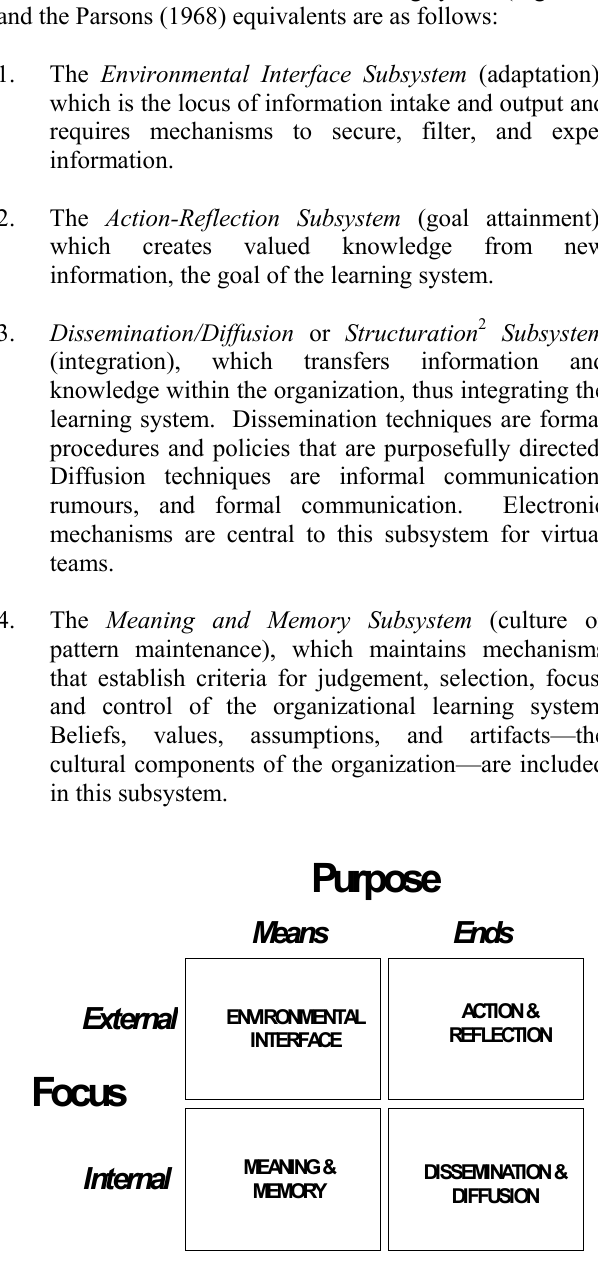
Figure 3: Schwandt’s learning